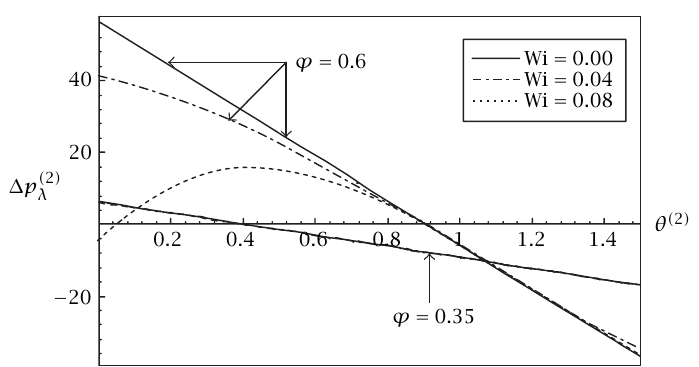
Figure 6.1 . The pressure rise versus flow rate at Re = 0 . 1, δ = 0 . 156, and ϕ = 0 . 35 , 0 . 6.